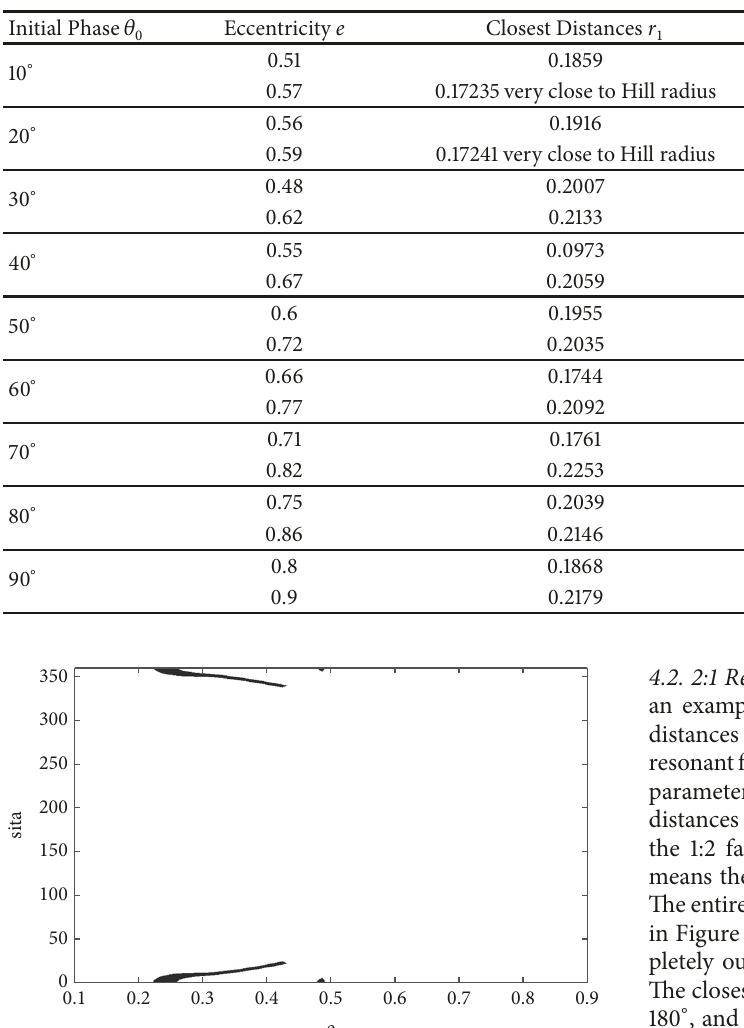
Table 3: Simulation results for 1:2 resonant orbits when the initial parameters can cause closest distance 𝑟 ROI ≤ 𝑟 1 ≤ 𝑟 Hill Kepler energy H 2 > 0.